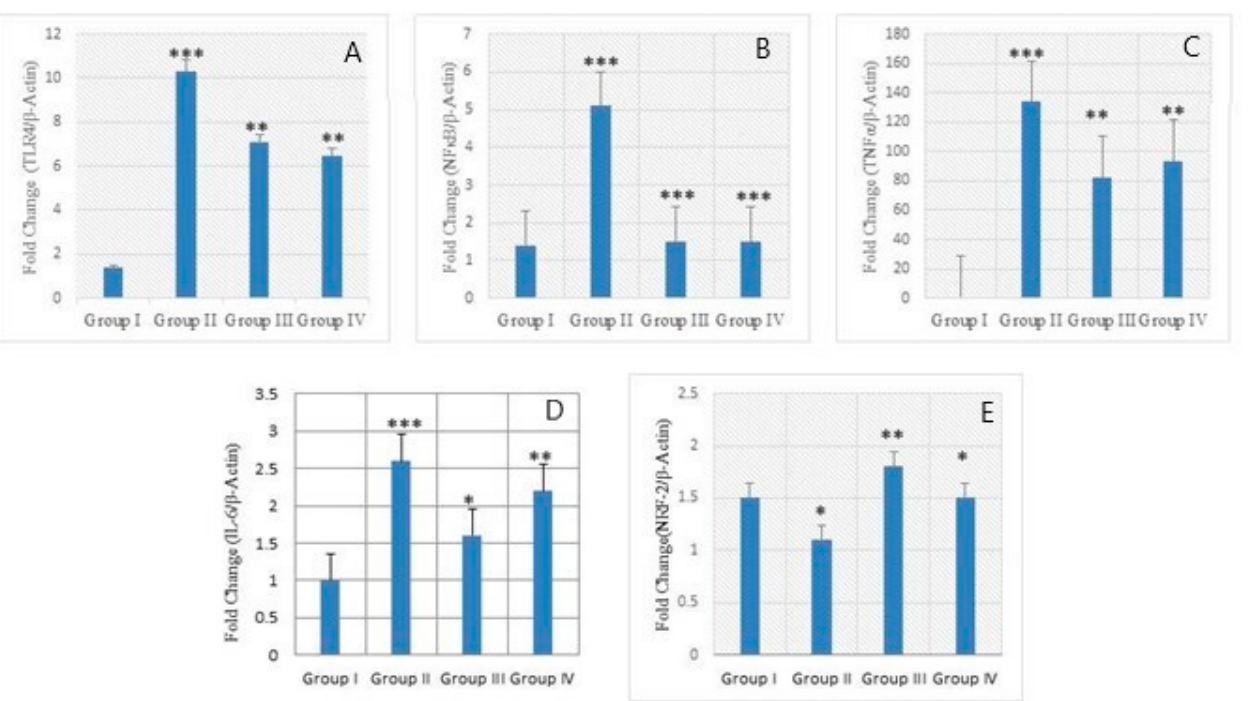
Figure 3. Relative expression of various genes in different groups of BuMECs normalized to housekeeping gene, β -Actin, using the qRTPCR technique. ( A ) TLR4 ( B ) NF κ B ( C )TNF α ( D ) IL-6 ( E ) NRF-2. Values represent mean ± SEM. Bars with ***, **, * represent p < 0.001, p < 0.01, and p < 0.05, respectively. Different superscript letters denote significant differences ( p < 0.05). Comparison of Group II with Group I and Group III, IV with Group II has been conducted.